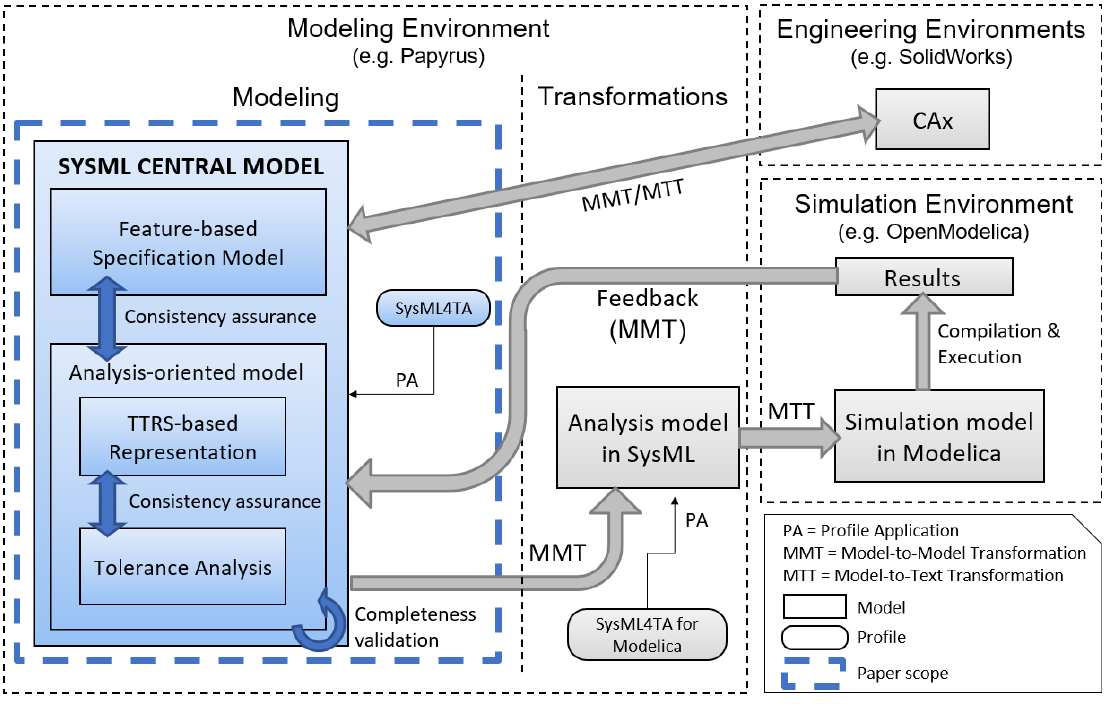
Figure 1. Proposal framework.